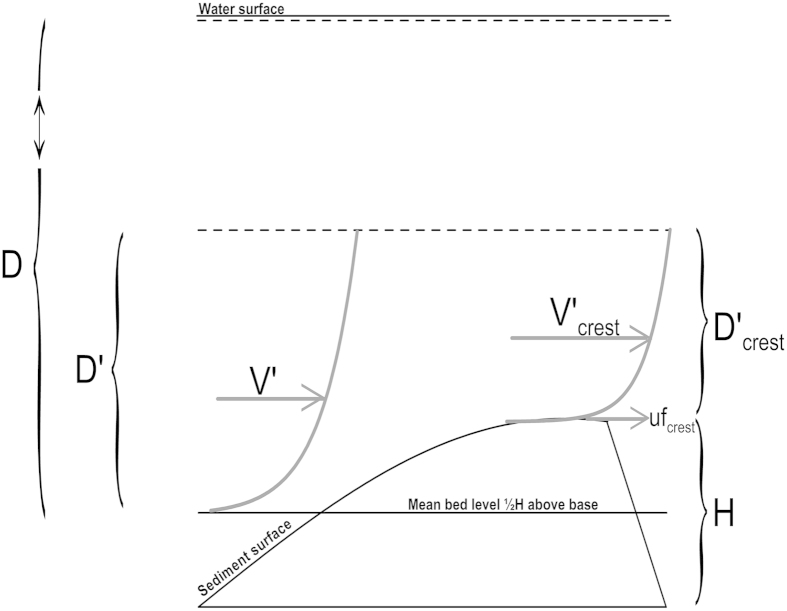
The concept of a virtual boundary layer above bedforms.The thickness of the layer D′ is smaller than or equal to the flow depth D. The mean velocity V′ within the layer increases as it contracts up the stoss side of the bedform to V′crest controlling the friction velocity ufcrest at the bedform crest.